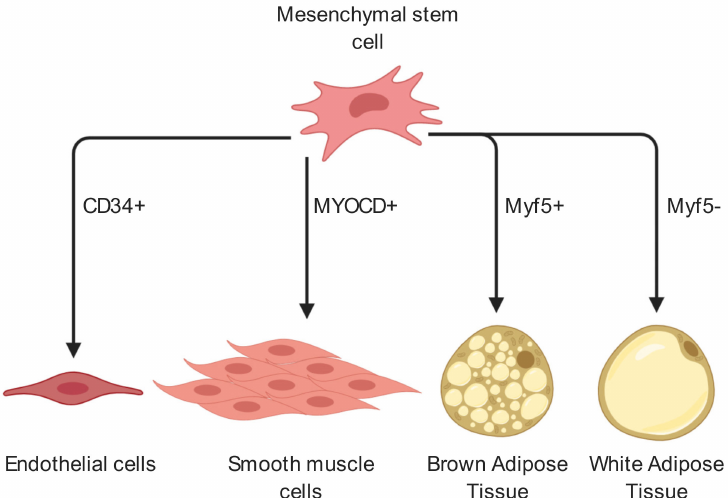
Figure 1. Cell fate of mesenchymal stem cells related to angiogenesis and adipogenesis. MSCs in adipose tissue may di ff erentiate into a variety of cell types including endothelial cells, smooth muscle cells as well as white or brown adipocytes and thereby contribute to angiogenesis and neovascularization. In adipogenesis, Myf5 + and Myf5- cells mark two distinct populations which diverge early in adipogenesis. Myf5 + cells will di ff erentiate into brown adipose tissue while Myf5- will di ff erentiate into white adipose tissue. CD34 is an endothelial cell marker, while MYOCD is a marker for smooth muscle cell di ff erentiation [20,21]. (Created with